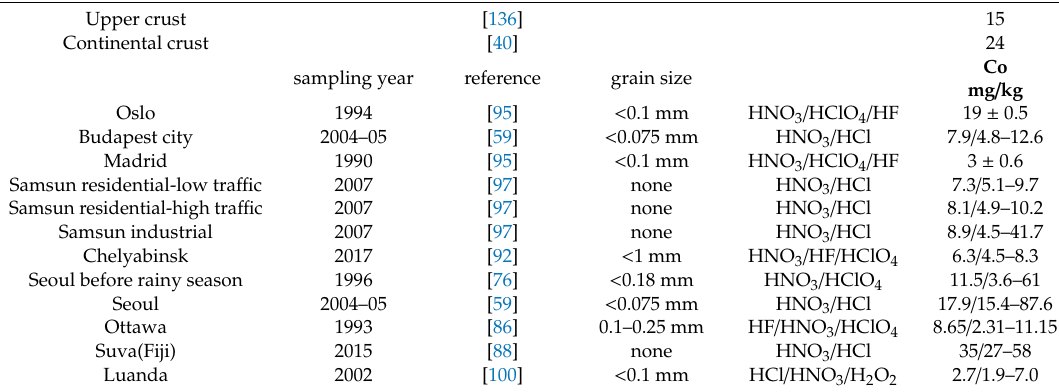
Table A27. Cobalt in road dust.